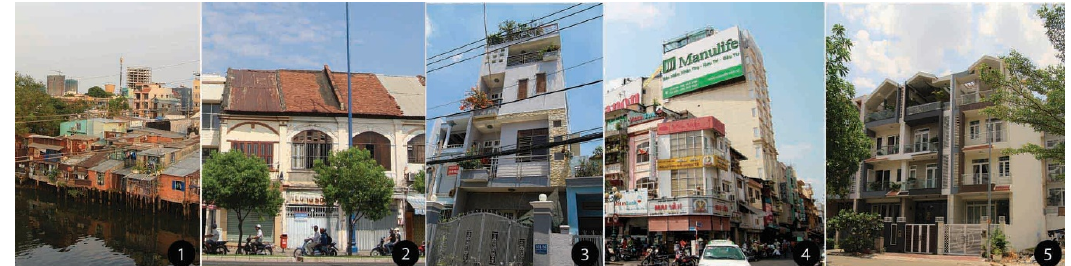
Figure 2. Five shophouse types found in HCMC: ( 1 ) rudimental shophouse; ( 2 ) traditional shophouse; ( 3 ) new shophouse; ( 4 ) commercial shophouse; and ( 5 ) row house.